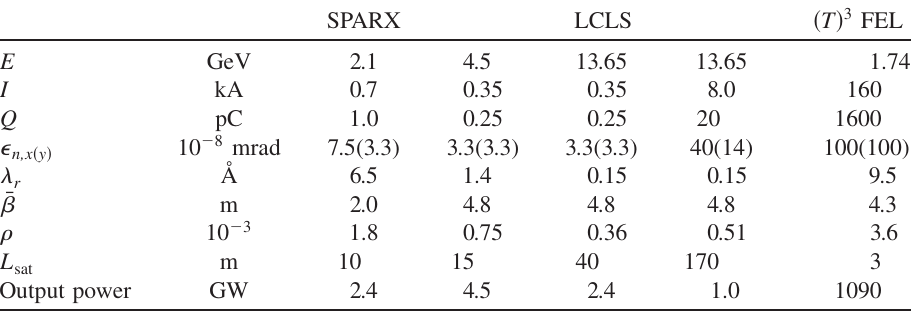
TABLE I. Summary of the results of the GENESIS free electron laser